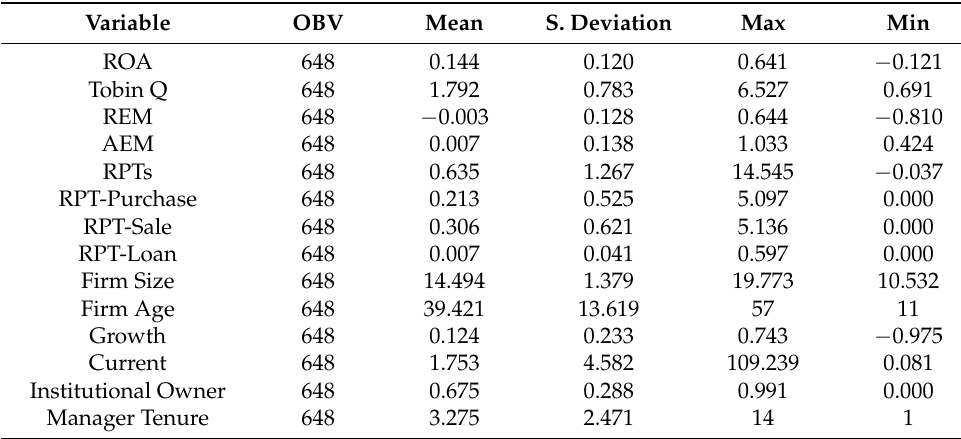
Table 3. Descriptive statistics of quantitative